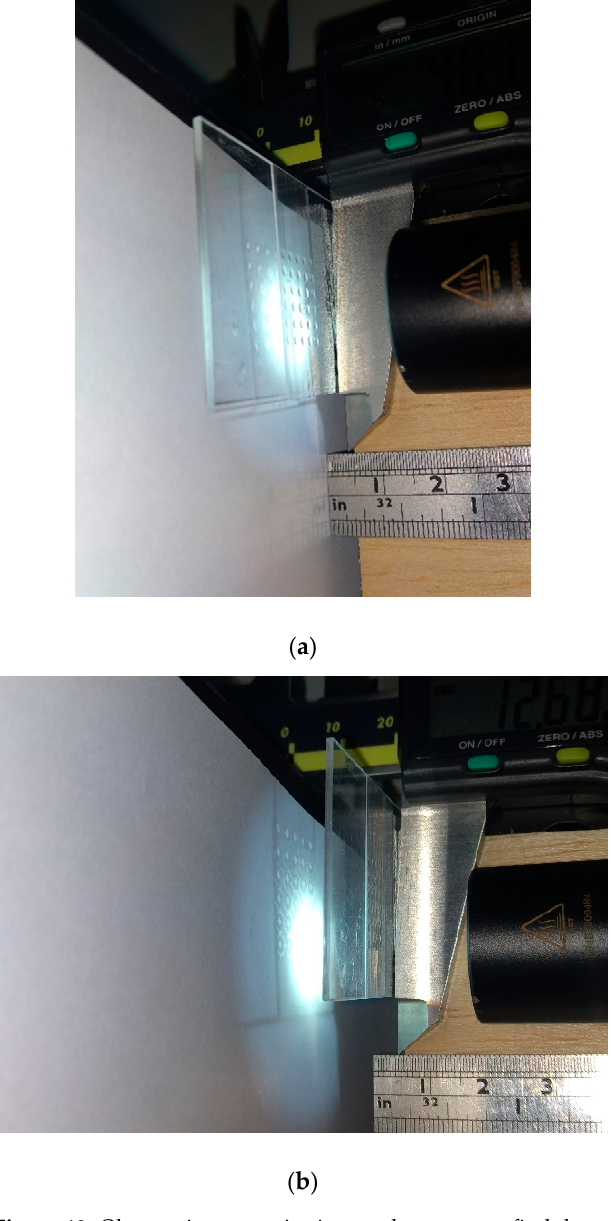
Figure 12. Observe image projecting on the screen to find the two conjugates. ( a ) The position of first conjugate. ( b ) The position of the second conjugate.